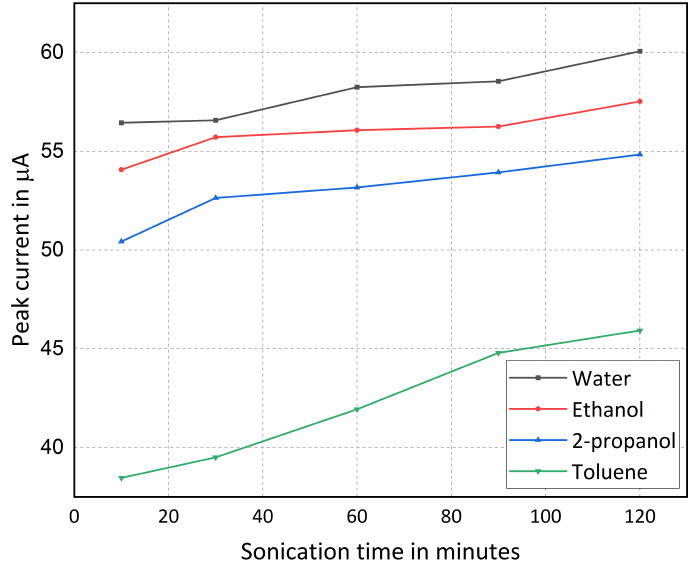
Figure 10. Comparison among the current peak values of electrode based on fMWCNT dispersion in different